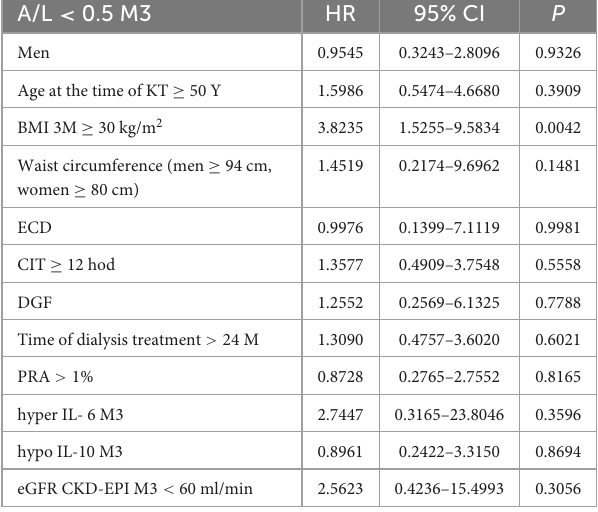
TABLE 5 Cox proportional hazard model, end point: A/L ratio < 0.5 at 3 months after kidney transplantation. A/L < 0.5 M3